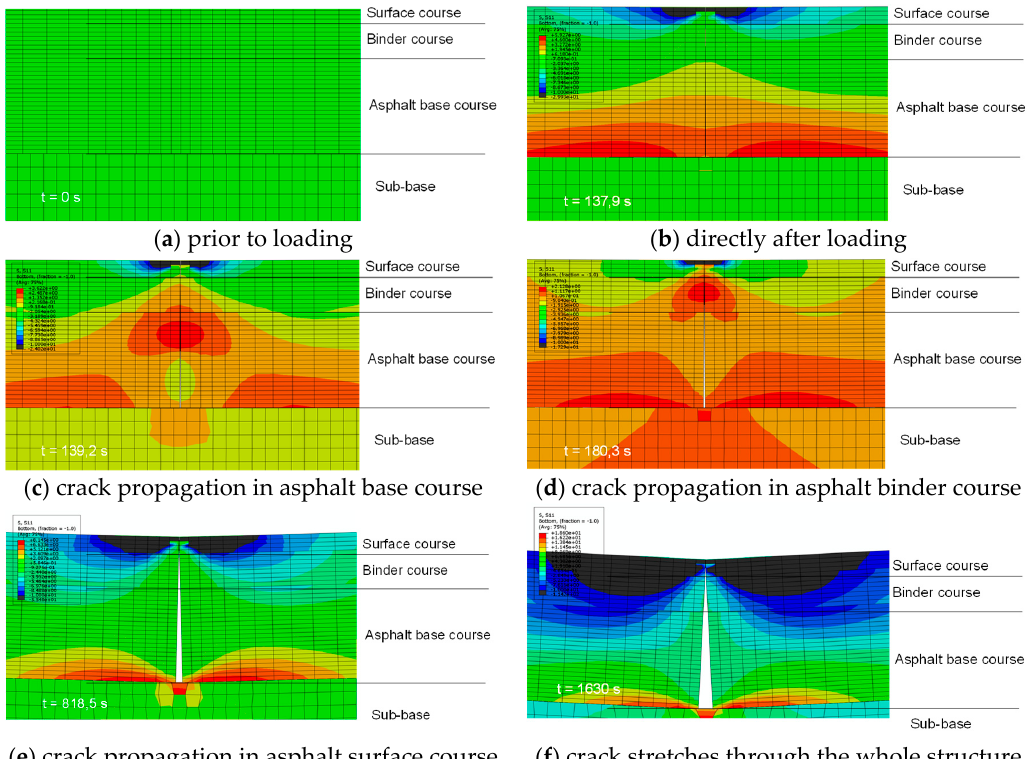
Figure 10. Stress distribution and crack propagation in numerical simulation with cohesive zone elements in ABAQUS (scale factor 100).